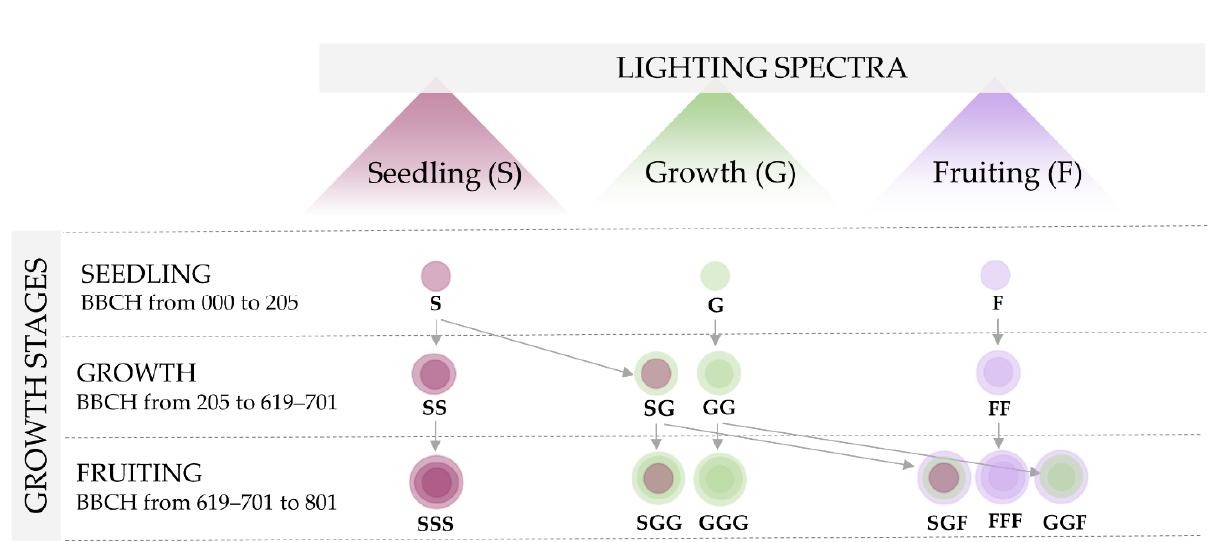
Figure 1. Experimental lighting design.